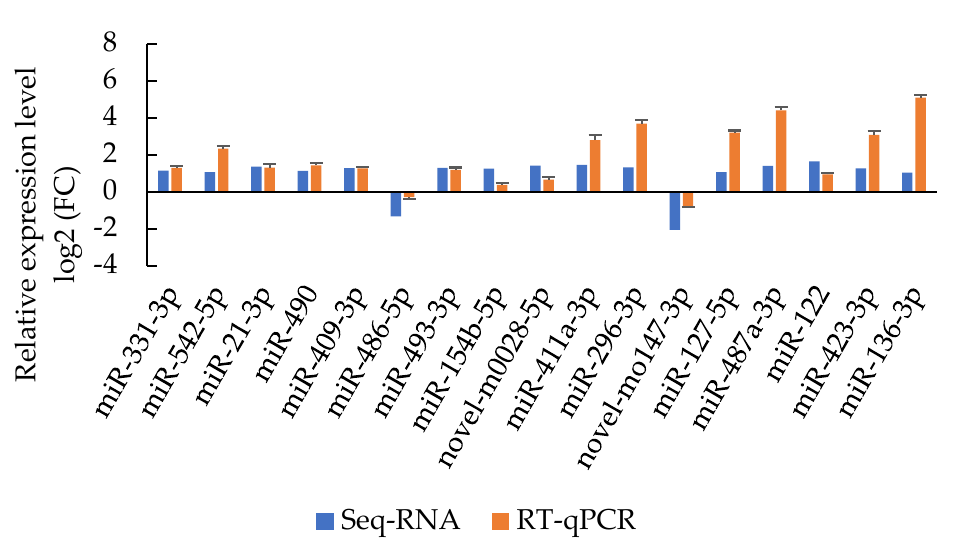
Figure 3. The comparison of results from RT-qPCR with those from small RNA-seq in skin tissue samples for 17 miRNAs. The error bars indicate the standard deviation of the mean values of three technological replicates for each sample.